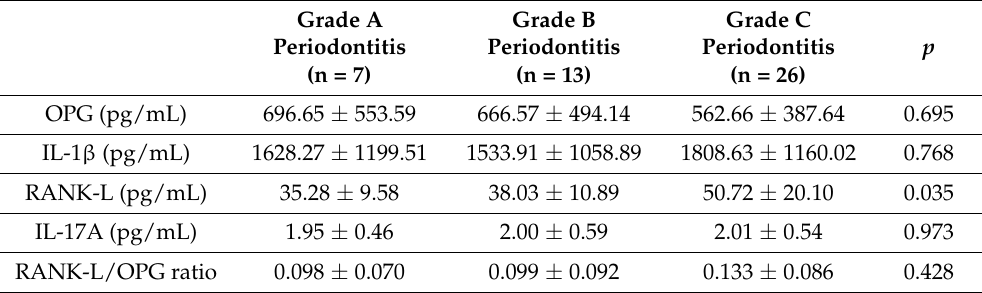
Table 4. OPG, IL-1 β , RANK-L, and IL-17A salivary levels in periodontitis grades A, B and C.